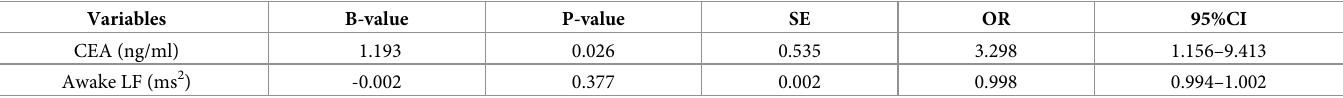
Table 2. Logistic regression analysis of factors independently associated with breast cancer.